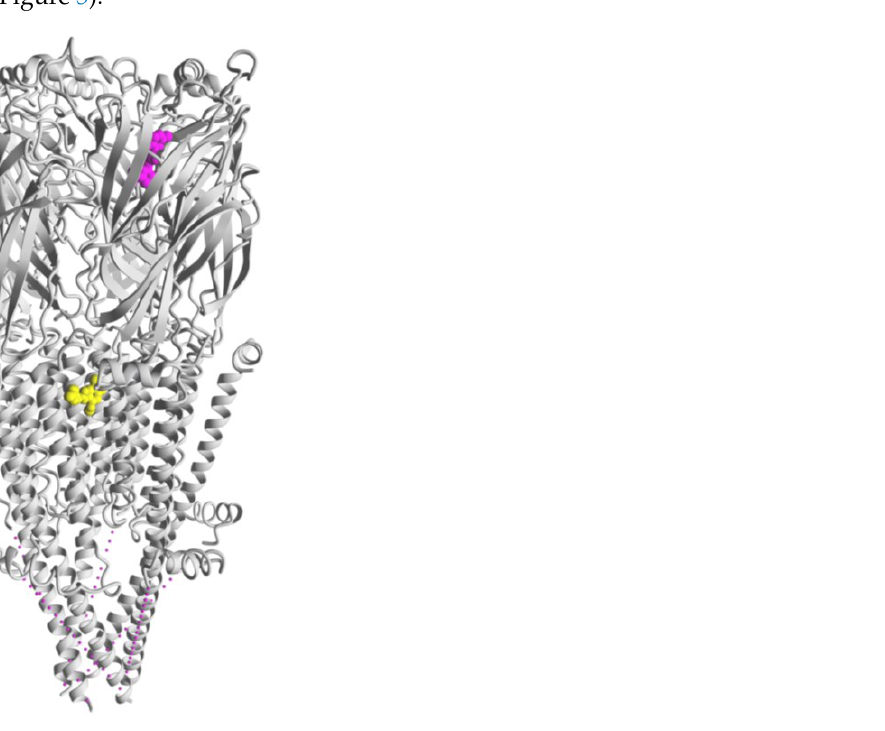
Figure 5. Cryo-EM structure of the human α 7 nAChR (pdb:7EKT) showing the intersubunit site for PNU-120596 (yellow), the archetype of type II PAMs, located in the TMD (modified from reference [58]). The ECD binding site for NS-1738 (magenta), a typical type I PAM, was obtained by molec- ular docking as previously described [31]. Only one of five sites per each PAM is shown for sim- plicity.